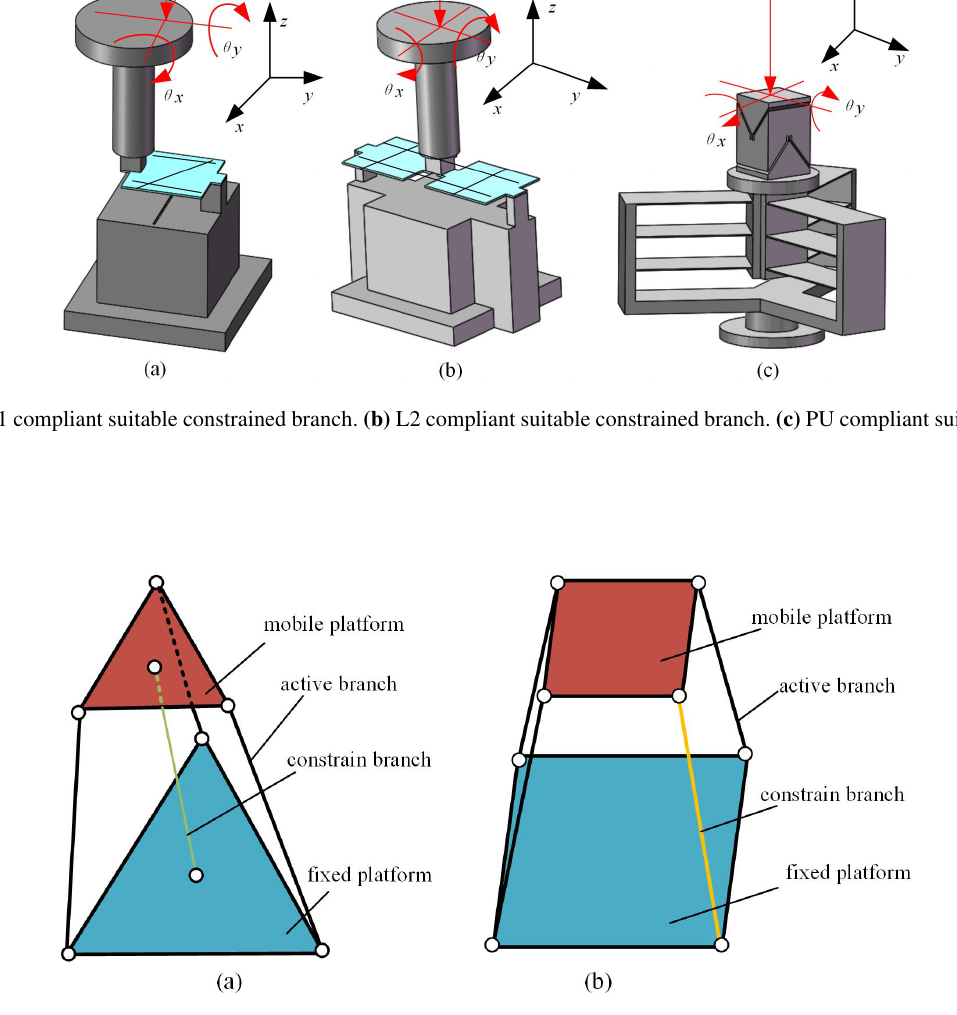
Figure 9. The two different arrangements for the compliant mechanisms. (a) Axis symmetric. (b) Plane symmetric.